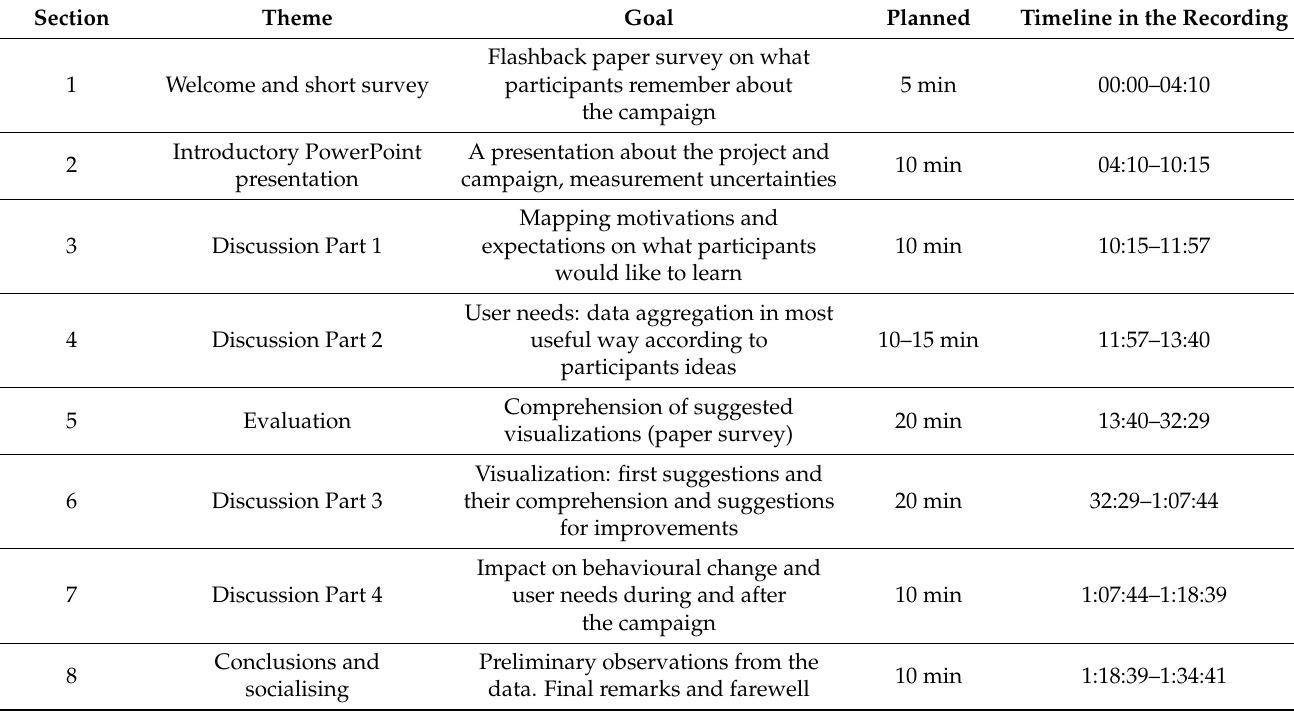
Table 2. Focus group